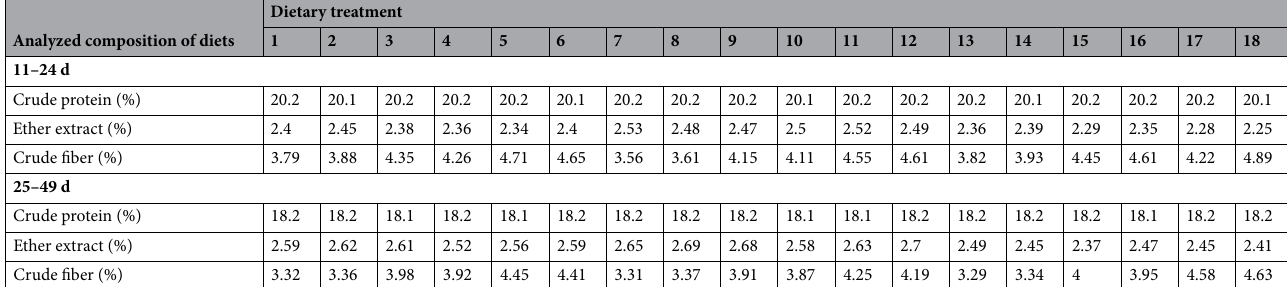
Table 3. Composition of the diets analyzed nutrient contents given to broilers